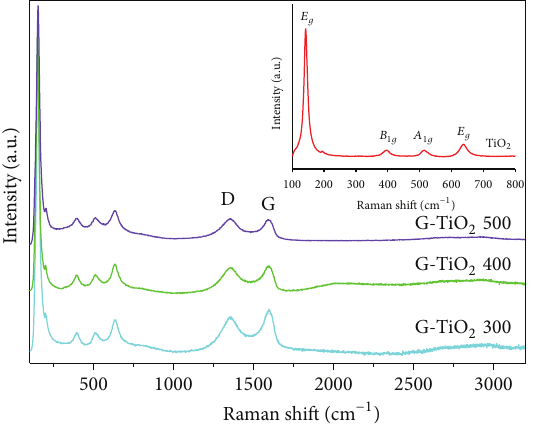
Figure 6: Raman spectra of G-TiO 2 electrodes sintered at various temperatures. The inset shows the typical peak positions for anatase TiO 2